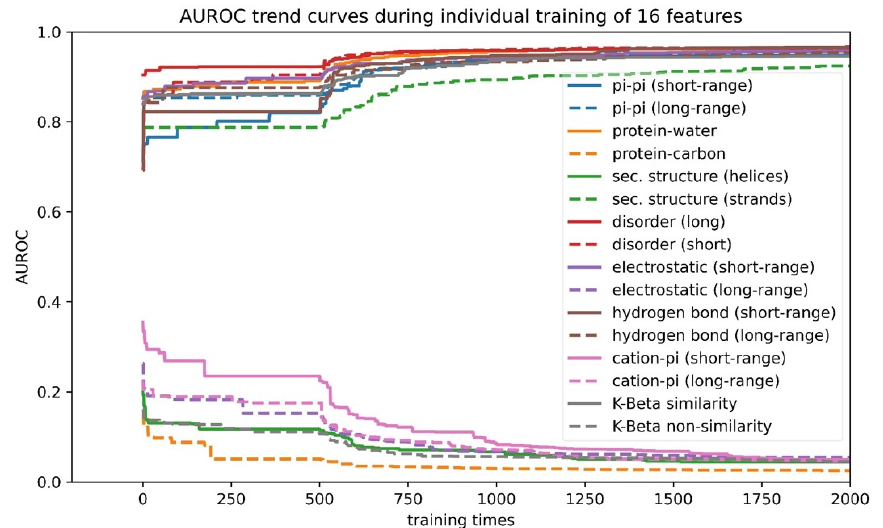
Figure 4. Direction of correlation of features with performance of the developing phase-separation predictor. Training curves of 16 features to reveal the direction of correlation of each feature with score. Features that rise towards AUROC = 1.0 have “positive” features; features that decline towards AUROC = 0.0 have “negative” signs.